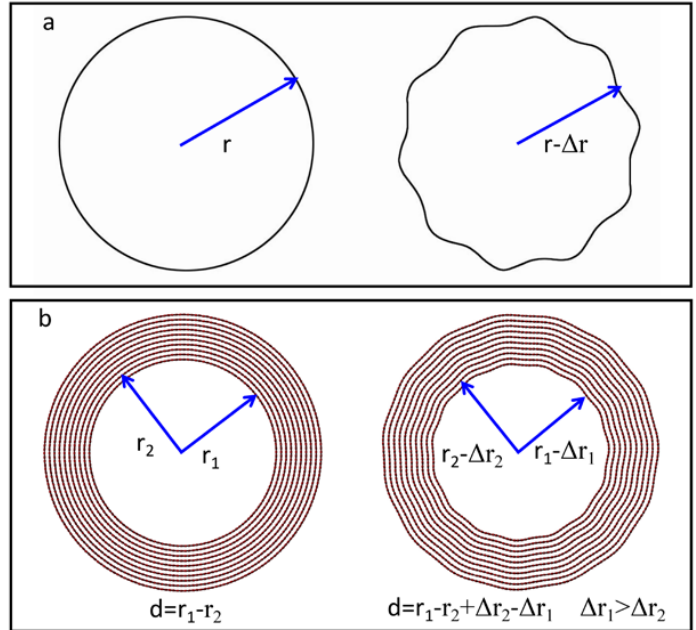
Figure 4. Schematic models for the contraction of innermost layer of nanotube due to the heating effect on the tubular structure (in the cross-section view). ( a ) The left-panel shows the schematic diagram without the wave-like atomic displacement, and the right-panel shows the lattice contraction caused by the wave-like atomic displacement; ( b ) Illustrative schematics of lattice contraction of innermost layers of multi-walled tubular structure upon in situ heating.